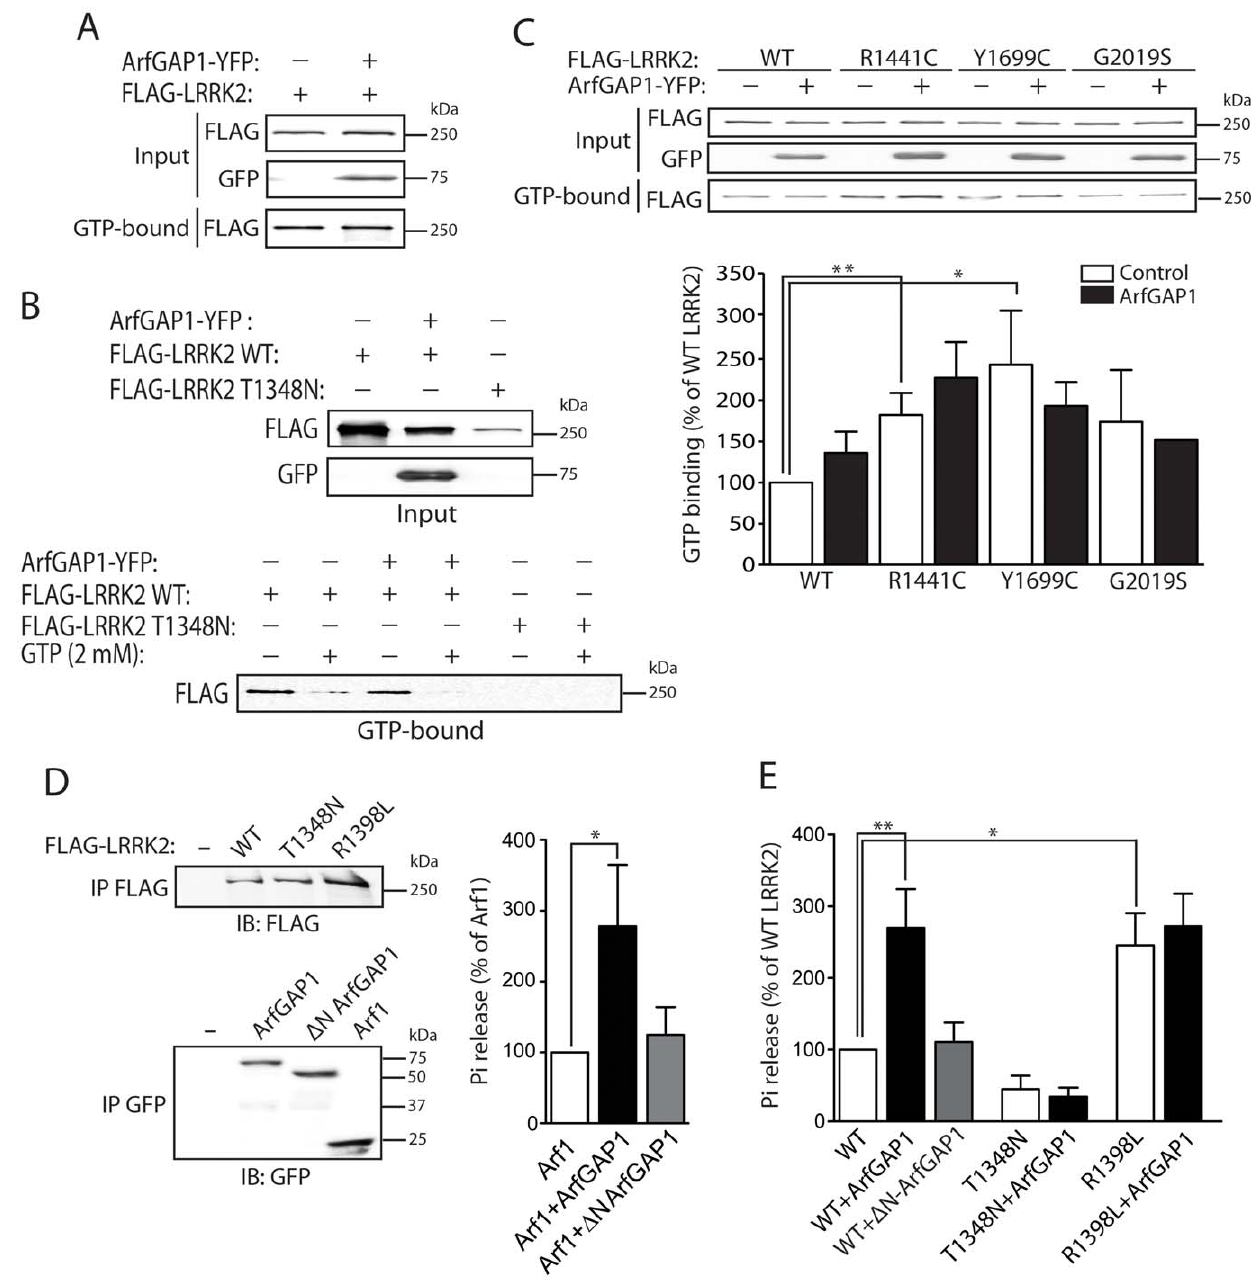
Figure 6. ArfGAP1 enhances the GTP hydrolysis activity of LRRK2. (A) ArfGAP1-YFP expression fails to influence the steady-state levels of FLAG-tagged WT LRRK2 bound to GTP following pull-down assays with GTP-sepharose from HEK-293T cells. (B) Confirmation of the specificity of LRRK2 GTP binding is indicated by negligible binding of the GDP/GTP binding-deficient LRRK2 mutant, T1348N. Competition with an excess of free GTP (2 mM) abolishes binding of WT LRRK2 to GTP-sepharose in the presence or absence of ArfGAP1. Each input lysate ( top panel ) was split equally and used for GTP pull-down assays in the presence or absence of free GTP ( lower panel ), as indicated. (C) ArfGAP1-YFP expression fails to influence the steady-state levels of GTP-bound WT and PD-associated mutant LRRK2. Densitometric analysis reveals a significant increase in GTP binding of the R1441C and Y1699C LRRK2 variants compared to WT LRRK2, independent of ArfGAP1 expression. Data represent the level of LRRK2 GTP binding expressed as a percent of WT LRRK2 levels. GTP-bound LRRK2 levels were normalized to LRRK2 input levels. Bars represent the mean 6 SEM ( n =3 experiments). * P , 0.05 and ** P , 0.01 compared to WT LRRK2 by one-way ANOVA with Newman-Keuls post-hoc analysis. (D) GTP hydrolysis activity of Arf1 in the presence or absence of full-length ArfGAP1 was determined by measuring the concentration of free phosphate (P i ) released from GTP. WT ArfGAP1 enhances Arf1-mediated GTP hydrolysis whereas D N ArfGAP1 has negligible effects on Arf1. The input levels of immunopurified Arf1-CFP and ArfGAP1-YFP variant were assessed by Western blot analysis with anti-GFP antibody ( lower panel ). (E) GTP hydrolysis activity of WT LRRK2 is significantly enhanced by WT ArfGAP1 but not by D N ArfGAP1. Guanine nucleotide-deficient T1348N LRRK2 exhibits impaired GTP hydrolysis activity, whereas the GTPase-hyperactive R1398L LRRK2 exhibits enhanced activity compared to WT LRRK2. The input levels of immunopurified FLAG-LRRK2 variants were assessed by Western blot analysis with anti-FLAG antibody (E, upper panel ), quantified by densitometry, and used for normalization of P i release between LRRK2 variants. GTP hydrolysis activity for Arf1 (D) or LRRK2 (E) is expressed as P i release as a percent of Arf1 or WT LRRK2 activity alone, as indicated. Bars represent the mean 6 SEM ( n =5 experiments). * P , 0.05 and ** P , 0.01 compared to Arf1 (D) or WT LRRK2 (E) by one-way ANOVA with Newman-Keuls post-hoc analysis. doi:10.1371/journal.pgen.1002526.g006 PLoS Genetics |